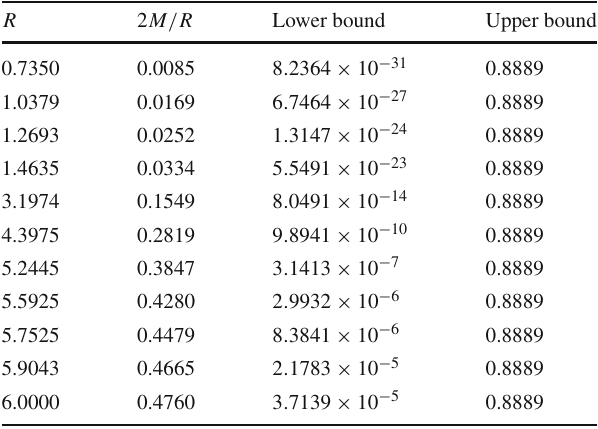
Table 4 Values of lower and upper bounds of mass for the values n =